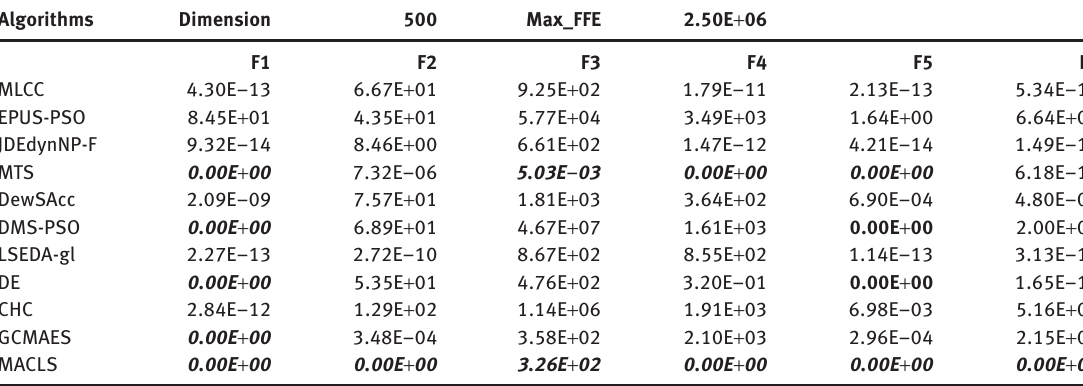
Table 7: Mean Error Values Achieved for Problems F1–F6, with D = 500. Algorithms